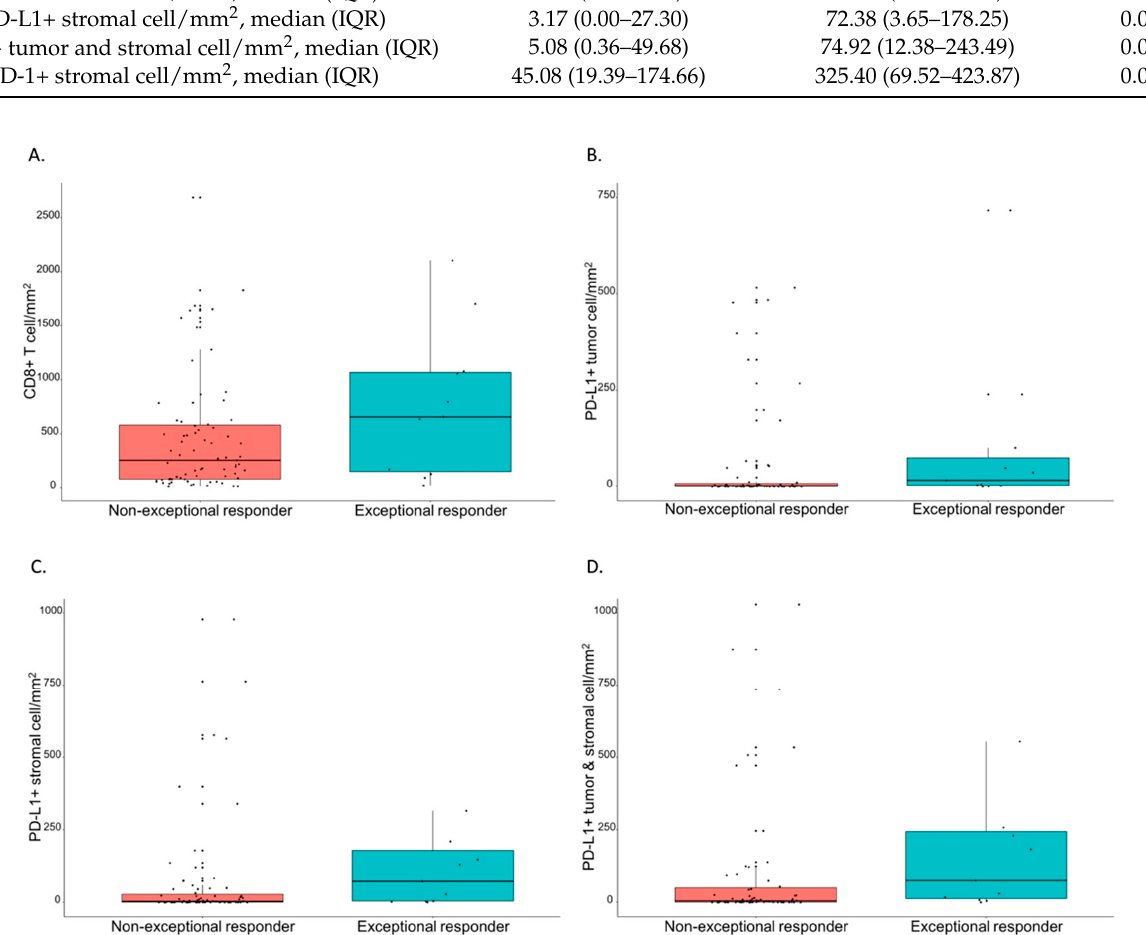
Figure 4. Immune profile according to patient groups: good responders and non-good responders. ( A ) CD8+ T cells, ( B ) PD-L1+ tumor cells, ( C ) PD-L1+ stromal cells, and ( D ) PD-L1+ tumor and stro- mal cells.